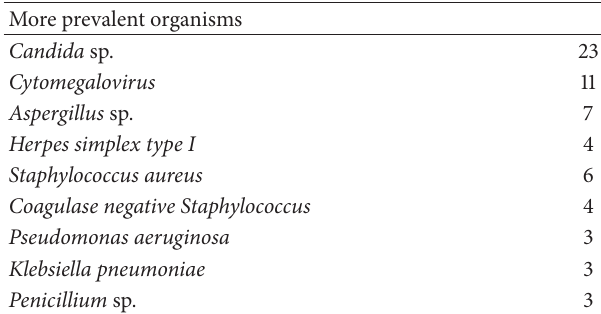
Table 5: Potential coinfecting organisms in non-HIV patients with